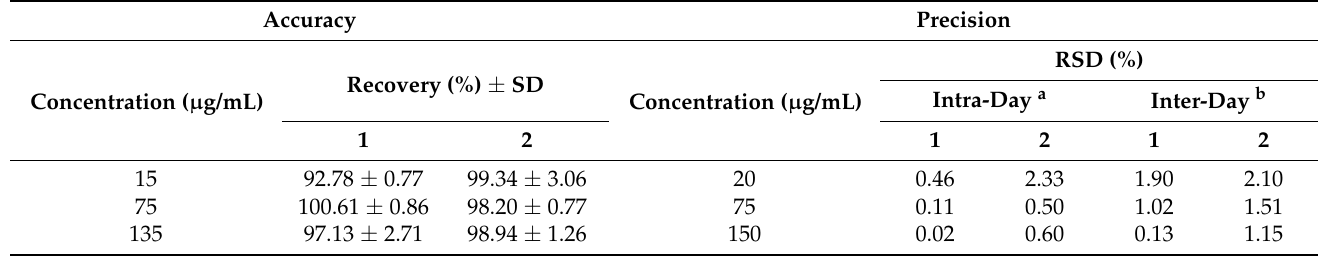
Table 3. Accuracy (% recovery) and intra- and inter-day precisions of 1 and 2 by the proposed HPLC